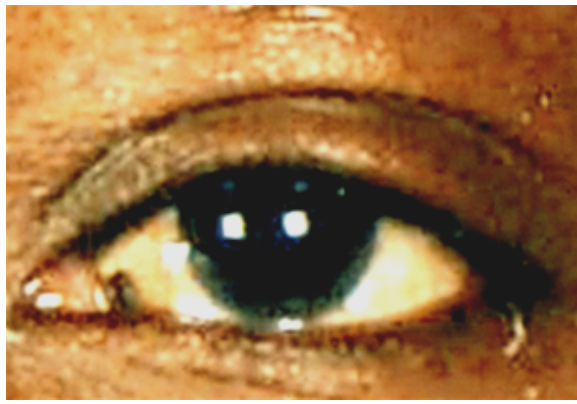
Figure 1: Clinical appearance of the lesion at first visit (LE)